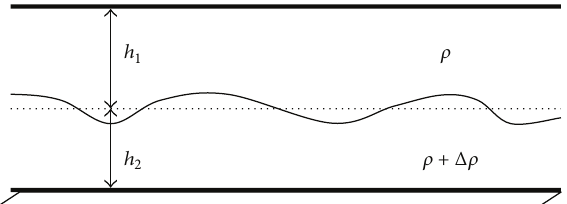
Figure 3: Scheme of the two-layer model.